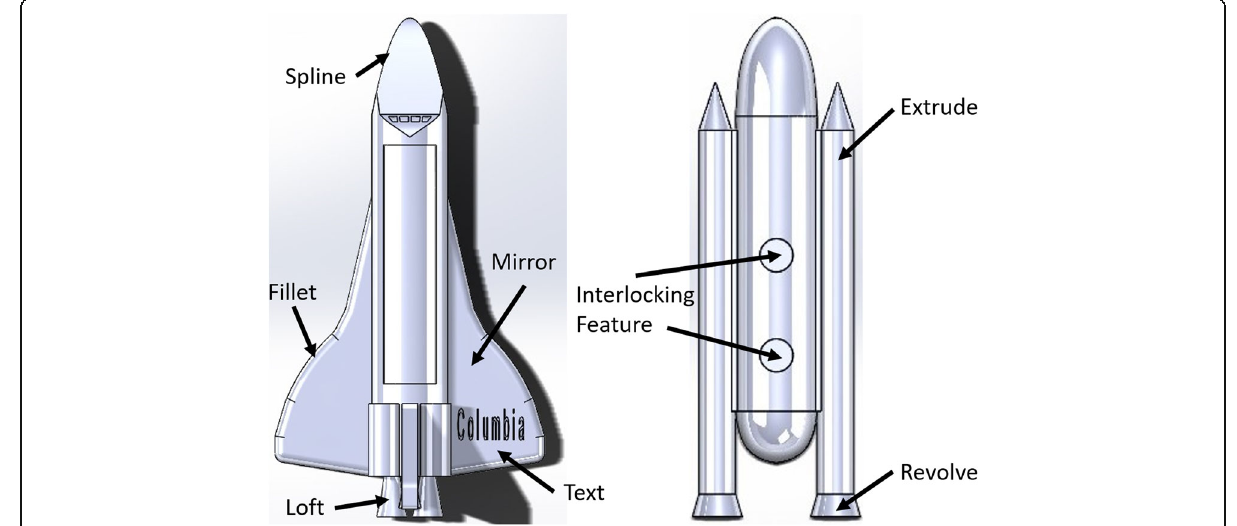
Fig. 3 Student submission for the individual project assignment